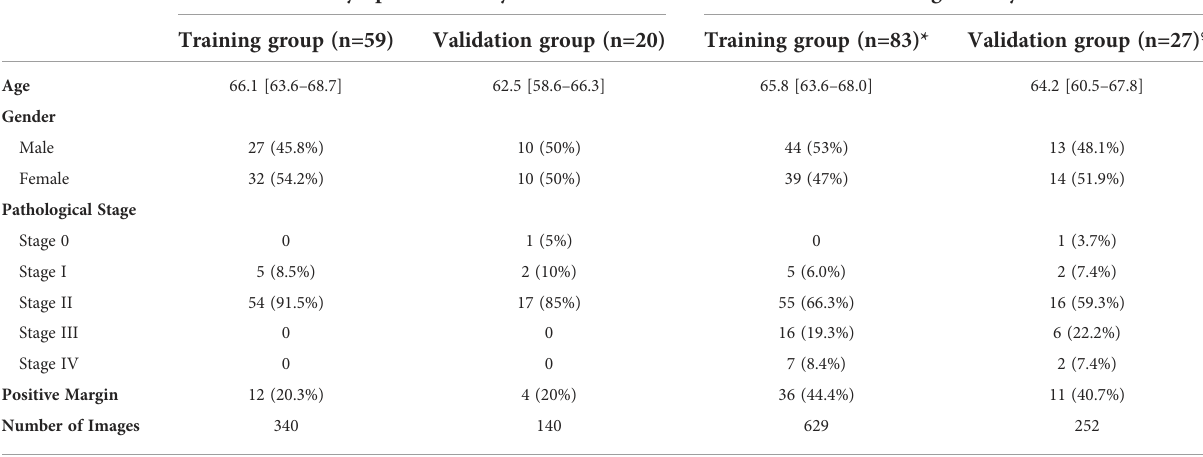
TABLE 1 Study population